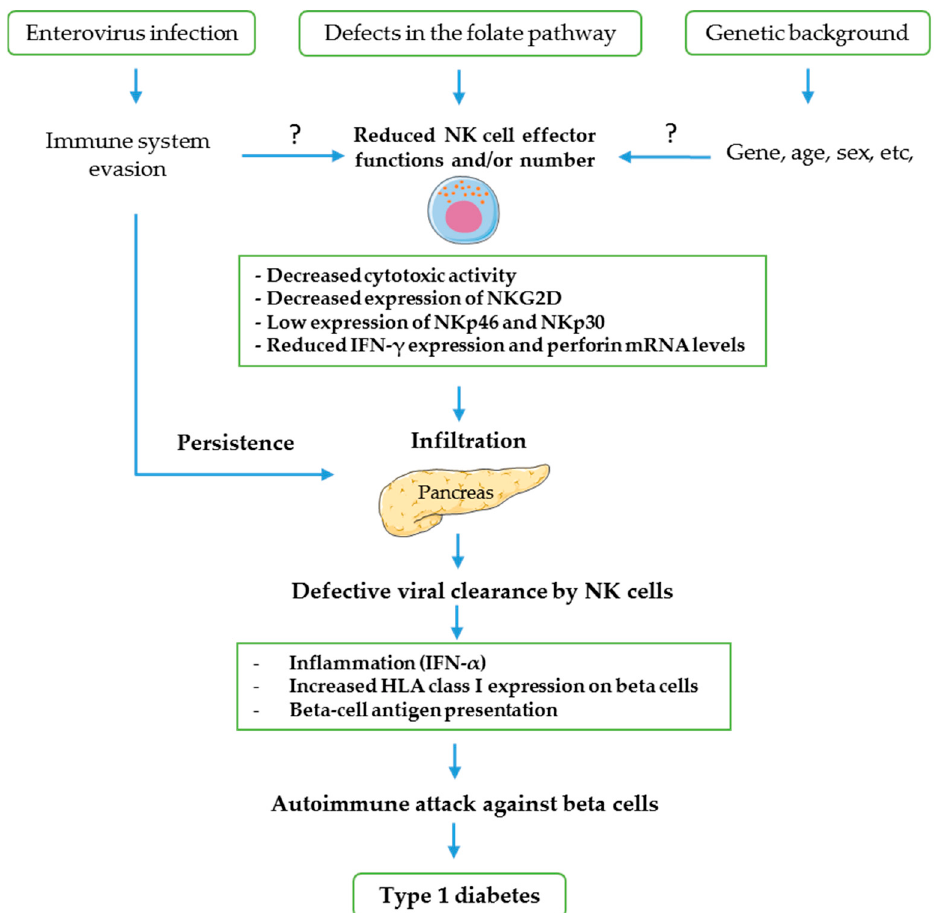
Figure 3. Enteroviruses have demonstrated the capacity to escape host antiviral defense by a ff ecting NK cell e ff ector response through unclear mechanisms. It has also been suggested that defects in folate pathway and a genetic background can play a role in reduction of number and activation of NK cells in T1D patients but the mechanisms are not fully understood. Therefore, a defective viral clearance by NK cells may play a role in the persistent enteroviral infection of pancreas which could induce a prolonged inflammatory response, beta cell antigen presentation and destruction of beta cells by preexisting antigen-specific CD8 cytotoxic T cells leading to